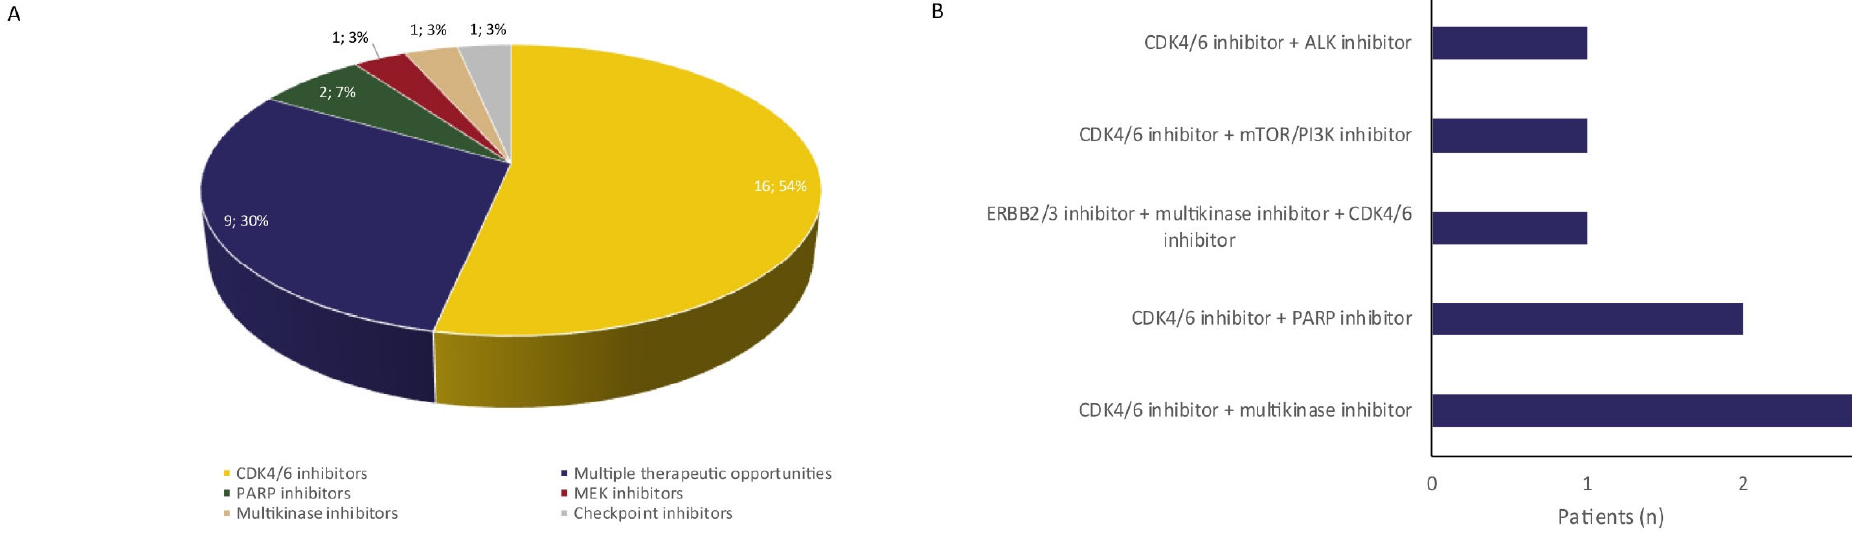
Figure 2. Experimental treatment opportunities identified with WGS. WGS identified experimental therapeutic opportunities for 30 patients ( A ), including eight patients with two experimental treatment opportunities ( B ).